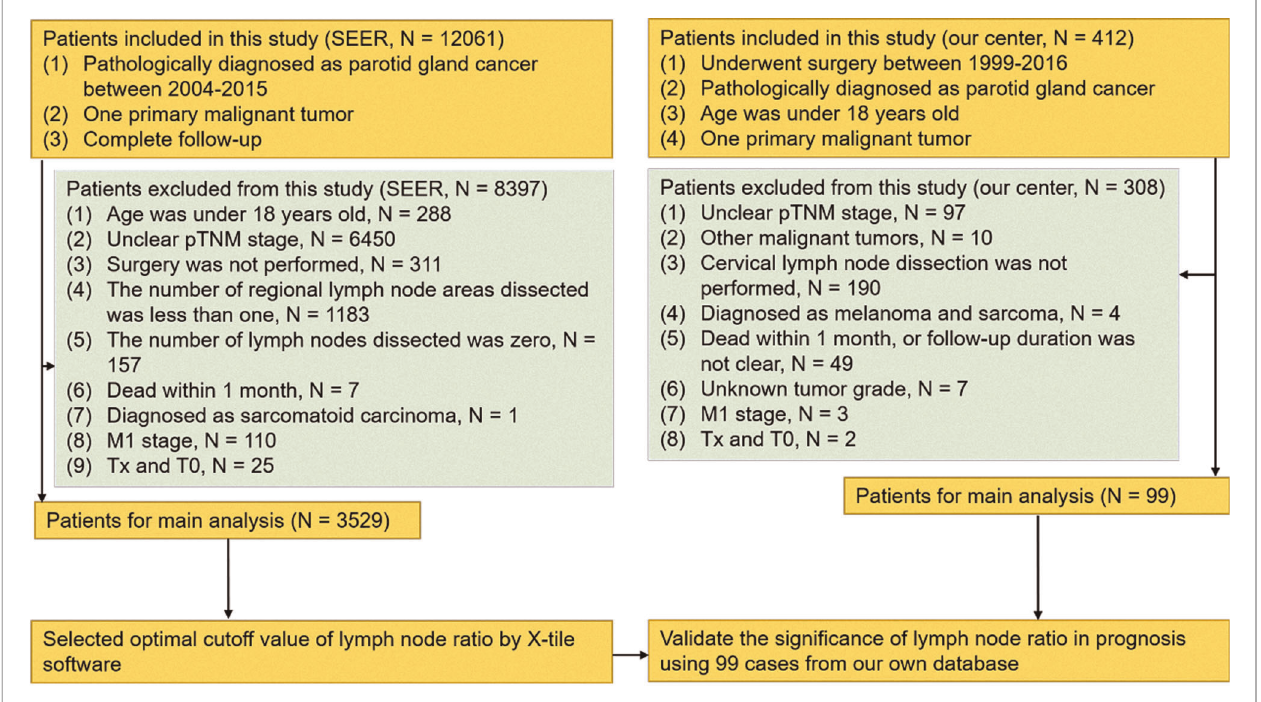
FIGURE 1 | Diagram of the patient screening process in the Surveillance Epidemiology and End Results and our center